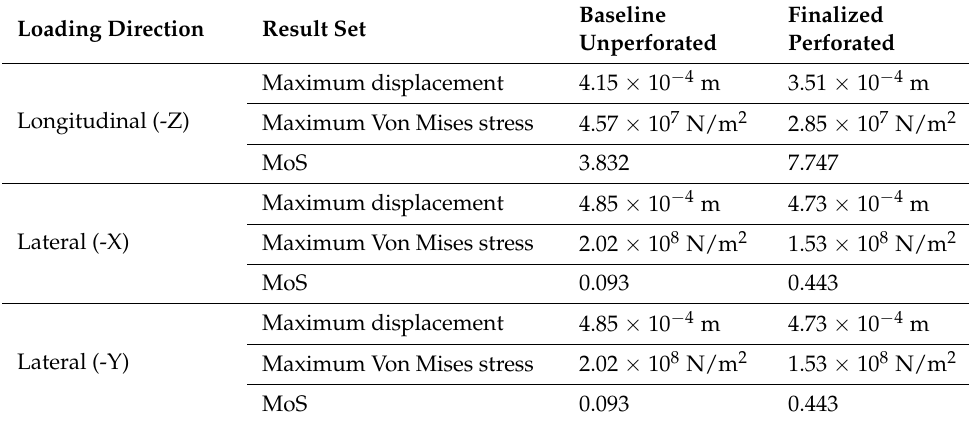
Table 10. Summary of quasi-static loading analysis